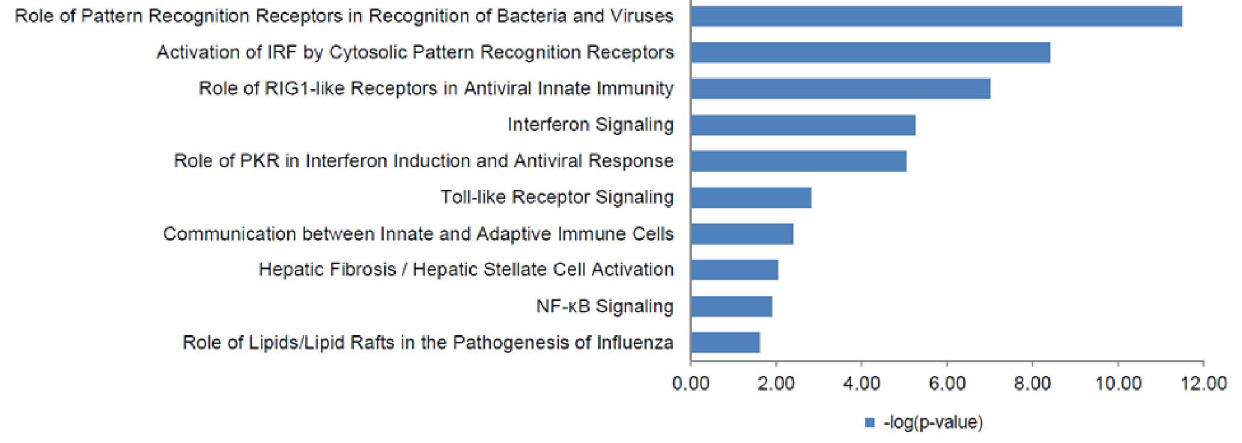
Figure 3. Signaling networks of genes that are associated with IFN responsiveness. The gene network was generated using Ingenuity Pathway Analysis software.